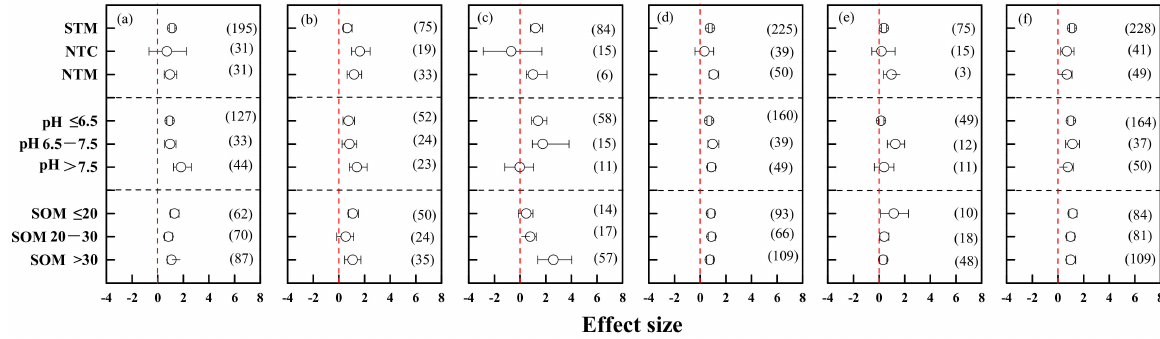
Figure 3. Effects of SDMI application on soil total N ( a ), available N ( b ), total P ( c ), available P ( d ), total K ( e ), and available K ( f ) under different environmental conditions, expressed as the mean effect size with bootstrap 95% confidence intervals. The number of observations for each category is given in parentheses. The differences between categories are significant if the probability level ( p ) is <0.05. The overall effect size is significantly positive or negative if 95% confidence interval does not overlap with zero at p = 0.05 level, and the difference in effect size between two categories is significant if 95% confidence intervals in the categories are not overlapping. NTC: northern temperate continental climate; NTM: northern temperate monsoon climate; STM: subtropical monsoon climate. SOM: soil organic matter content (g kg − 1